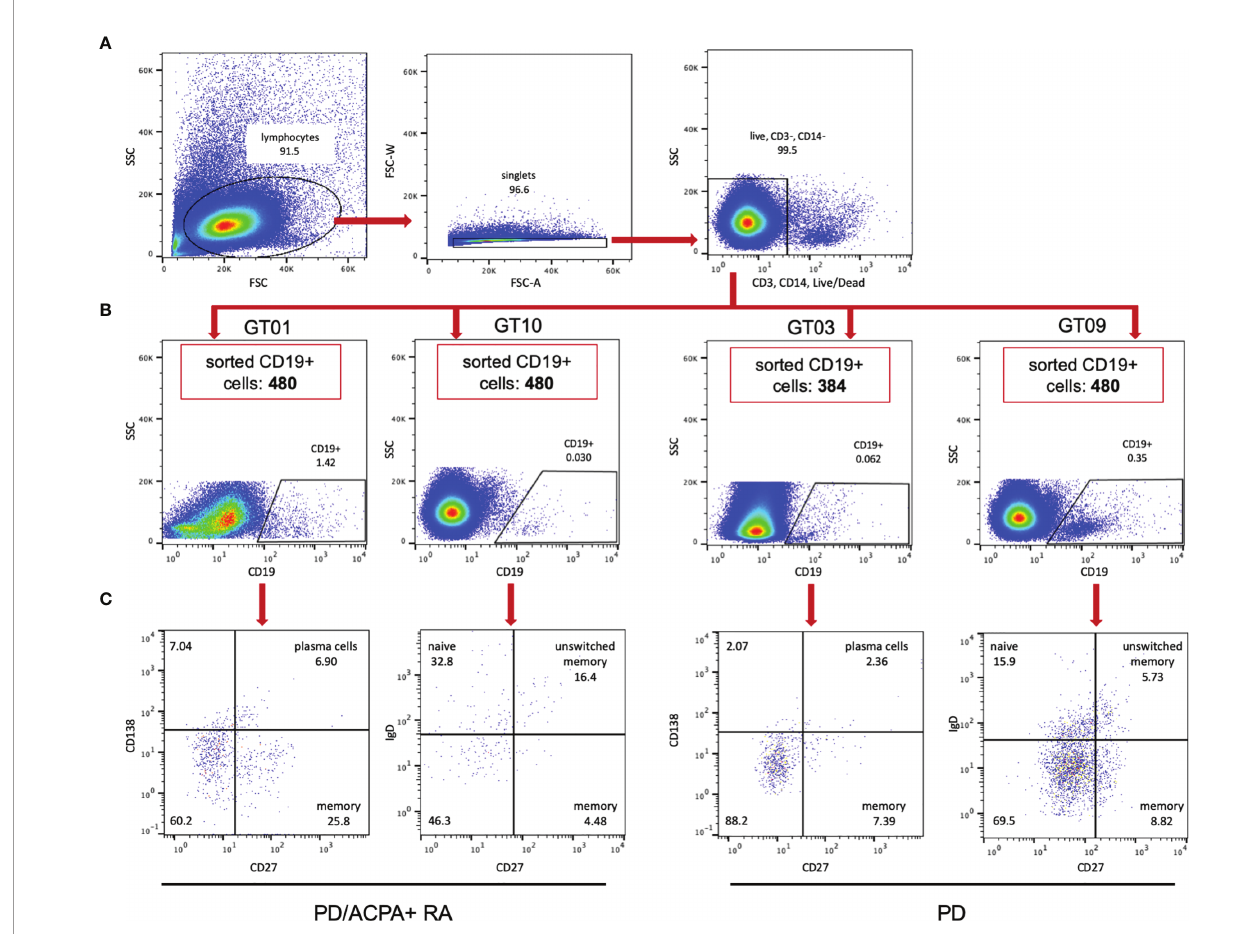
FIGURE 2 | Flow cytometry sorting of CD19+ B cells from gingival tissue biopsies. (A) Representative general gating strategy for CD19+ B cells from fresh GT biopsies. (B) Flow cytometry plots showing the frequency of CD19+ B cells after exclusion of dead, CD3+ and CD14+ cells; GT01 and GT10 originate from PD patients with ACPA+ RA (PD/ACPA+ RA), GT03 and GT09 originate from PD patients without RA (PD). (C) Flow cytometry plots showing the frequency of memory B cells (CD19+/CD27+/CD138-) and plasma cells (CD19+/CD27+/CD138+) in GT01 and GT03, or memory B cells (CD19+/CD27+/IgD-), naïve B cells (CD19+/ CD27-/IgD+) and unswitched memory B cells (CD19+/CD27+/IgD+) in GT10 and GT09. Red boxes show the number of CD19+ B cells sorted from each biopsy. FSC, forward scatter; SSC, side scatter; GT, gingival tissue; PD, periodontitis; ACPA, anti-citrullinated protein antibody; RA, rheumatoid